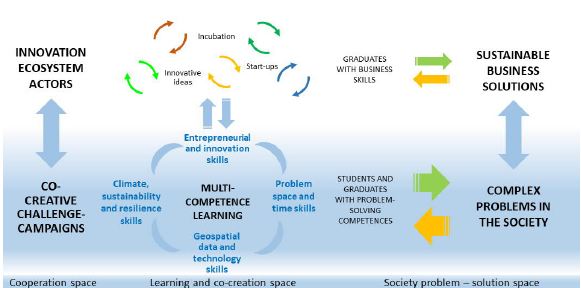
Figure 1 . GeoICT4e is aiming for socially innovative geospatial and ICT education transformation, which endorses multi-competence learning (MCL) opportunities of the